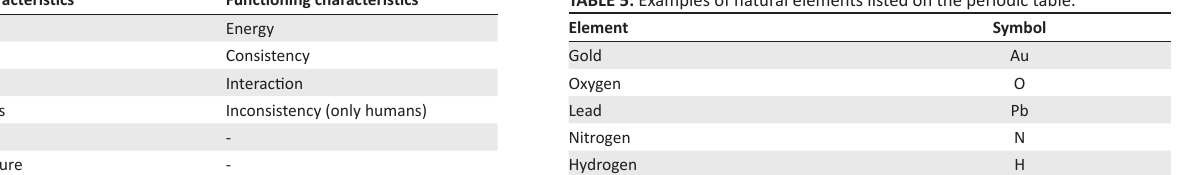
TABLE 4: Structural and functioning characteristics of safety hazards. Structural characteristics TABLE 5: Examples of natural elements listed on the periodic table.